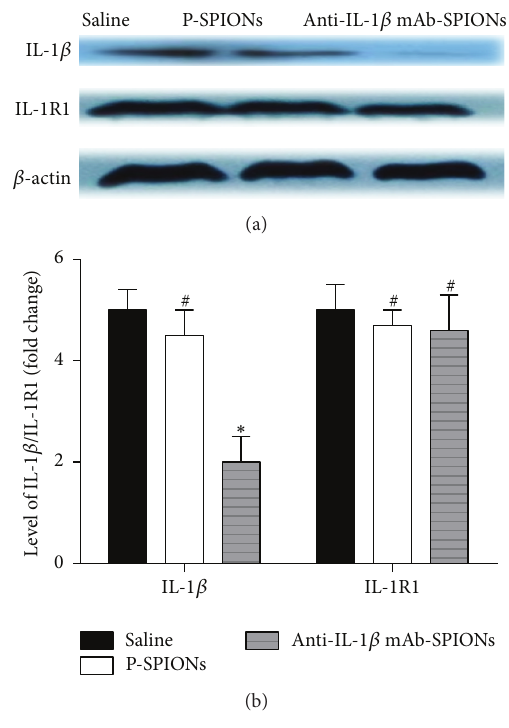
Figure 3: The protein expression of IL-1 𝛽 /IL-1R1(mean ± SD, 𝑛 = 5 ) measured in the rat hippocampus after particle injection, as assessed by Western blot. (a) Western immunoblots for IL-1 𝛽 and IL-1R1 protein expression in the saline, P-SPIONs, and anti-IL-1 𝛽 mAb- SPIONs groups. (b) shows bar graphs for IL-1 𝛽 and IL-1R1 protein expression plotted on the vertical-axis as a fold change relative to the saline group. ∗ 𝑃 < 0.05 versus saline group and P-SPIONs group; # 𝑃 > 0.05 versus saline group.